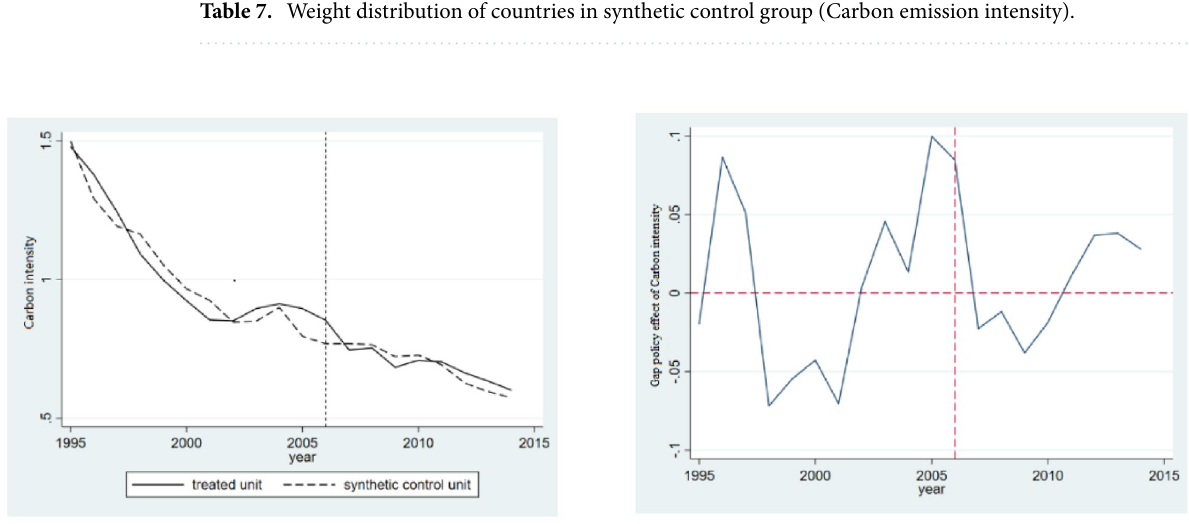
Figure 2. Carbon emission intensity estimated by